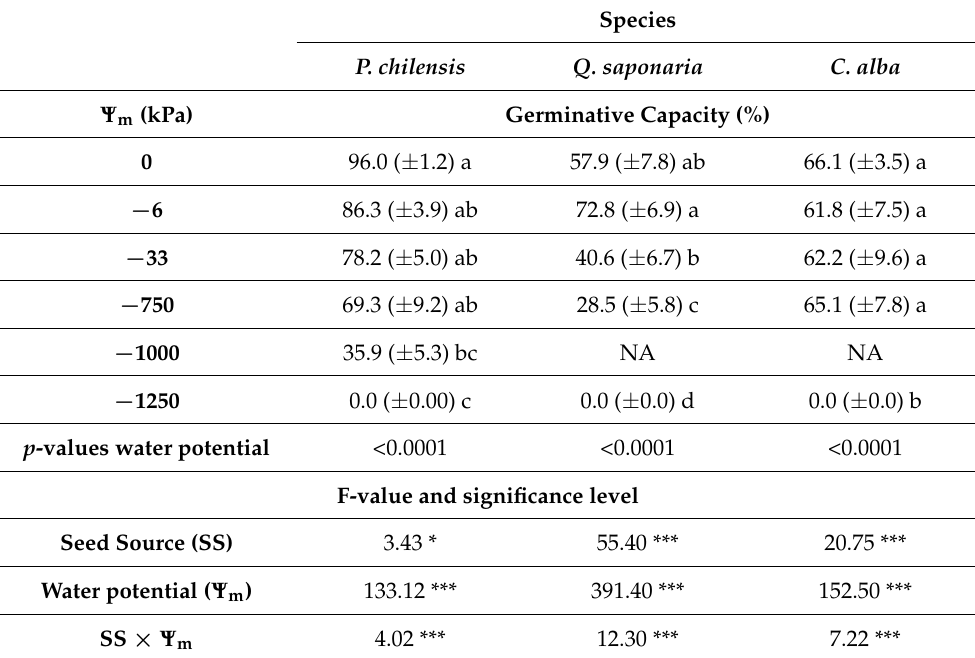
Table 1. Germination capacity (%) for each species according to matric potential ( Ψ m ) ( n = 3). Means, ± SE. Letters indicate significant differences among matric potential in each species for all seed sources. According to ANOVA, and LSD-Fisher multiple comparison test ( p < 0.05). NA = not measured. (F value: p < 0.05 *; p < 0.01 *** p <